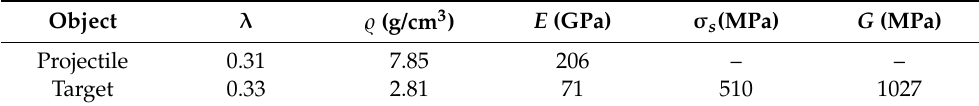
Table 1. Mechanical properties of